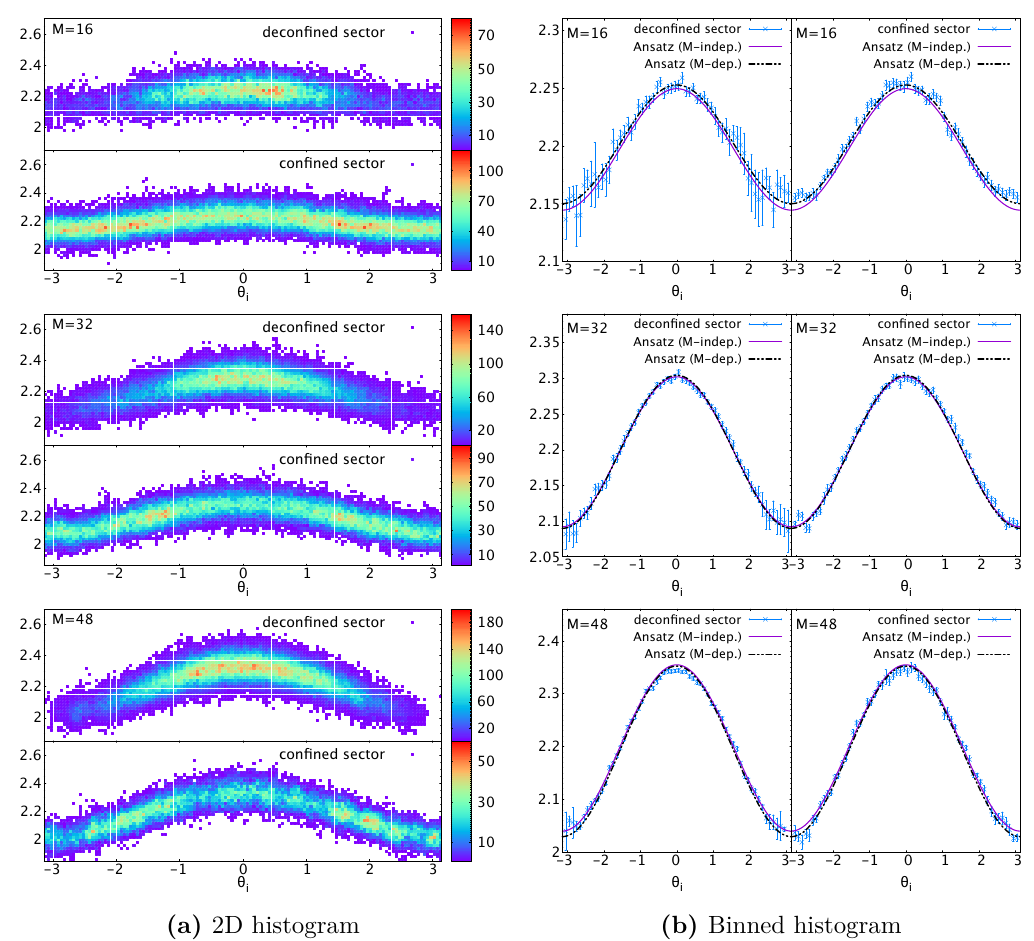
Figure 19. Yang-Mills matrix model, θ i vs K i , in a constrained simulation with N = 64 , L = 24 , M = 16 , 32 and 48 at T = 0 . 885 . Same as figure 18, except that the confined and deconfined sectors are shown separately, and ∆ θ = 0 . 1 is used for (b). The total number of the data points are M × 1500 and (64 − M ) × 1500 for the deconfined and confined sectors, respectively.